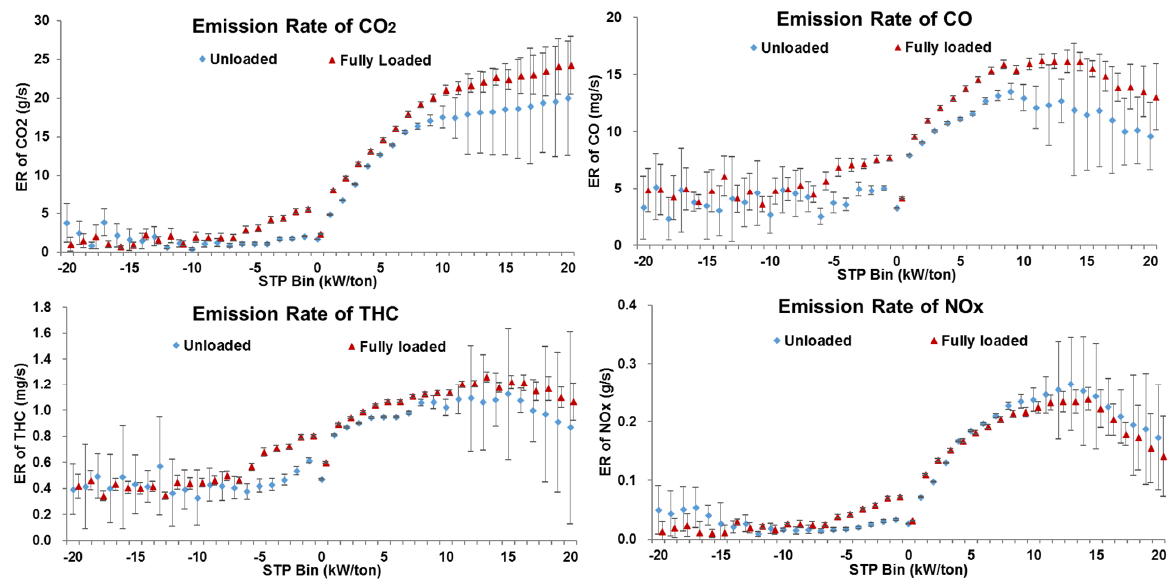
Figure 6. Emission rates of CO 2 , CO, THC and NO x for DSTTTs with unloaded and fully loaded in STP bins. (with 95% confidence intervals).